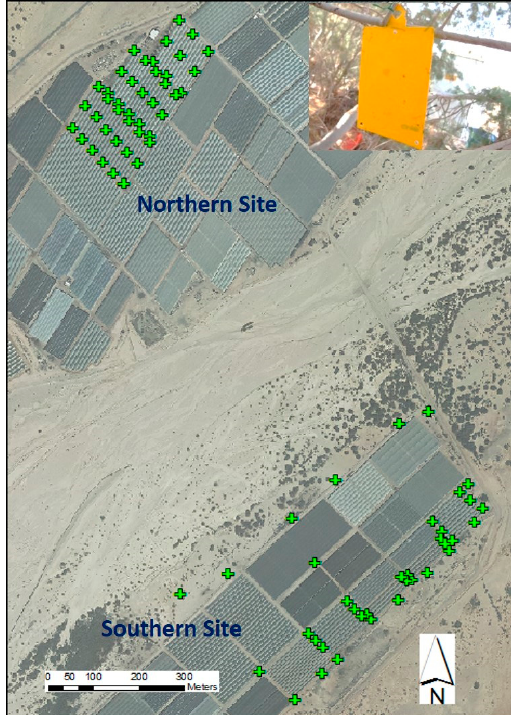
Figure 3. Aerial image of the northern and southern melon growing sites in Ein Yahav and position of yellow sticky trap boards (green crosses) used to monitor the Ethiopian fruit fly during 2014. The insert picture shows a Rimi ® yellow sticky trap board (YSB). YSB were suspended in entrances of greenhouses (gray lines in the aerial photo), and in surrounding vegetation.